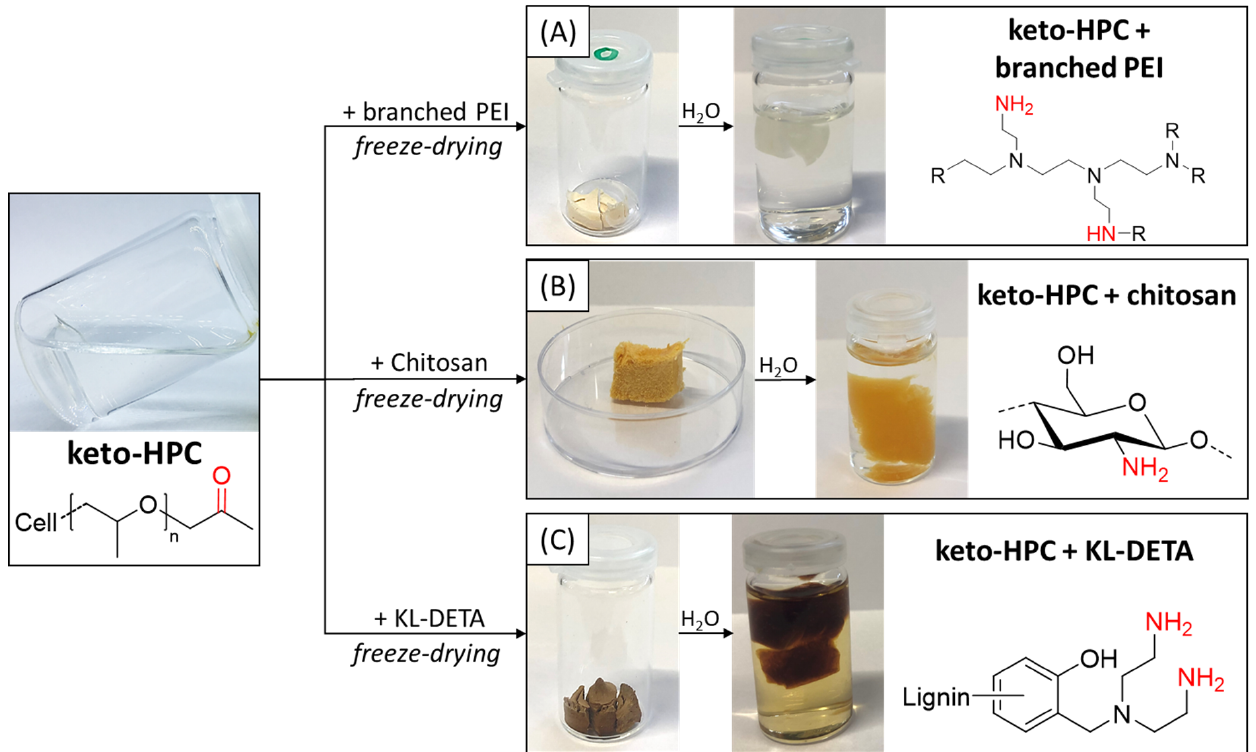
Figure 3. Hydrogels made from keto-HPC ( A ) with PEI ( B ) with chitosan and ( C ) KL-DETA.